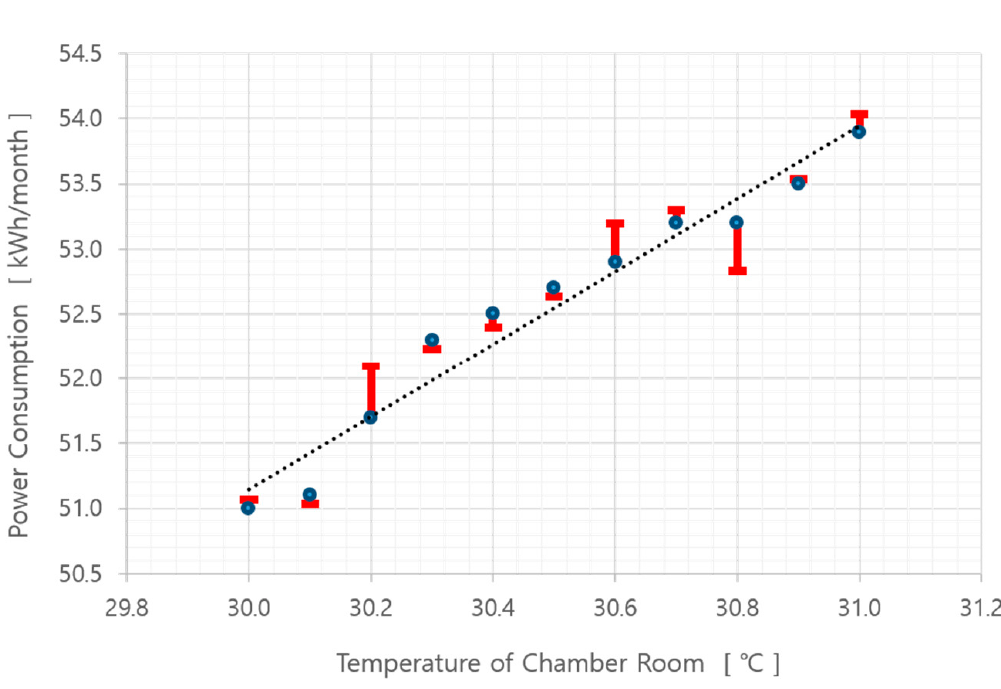
Figure 7. Monthly power consumption for various temperatures in the chamber room.